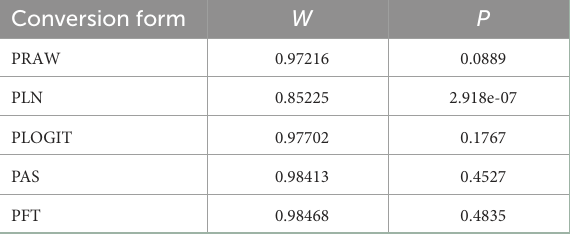
TABLE 7 Normal distribution test for the normal rate and the different conversion of the normal rate. Conversion form W P PRAW